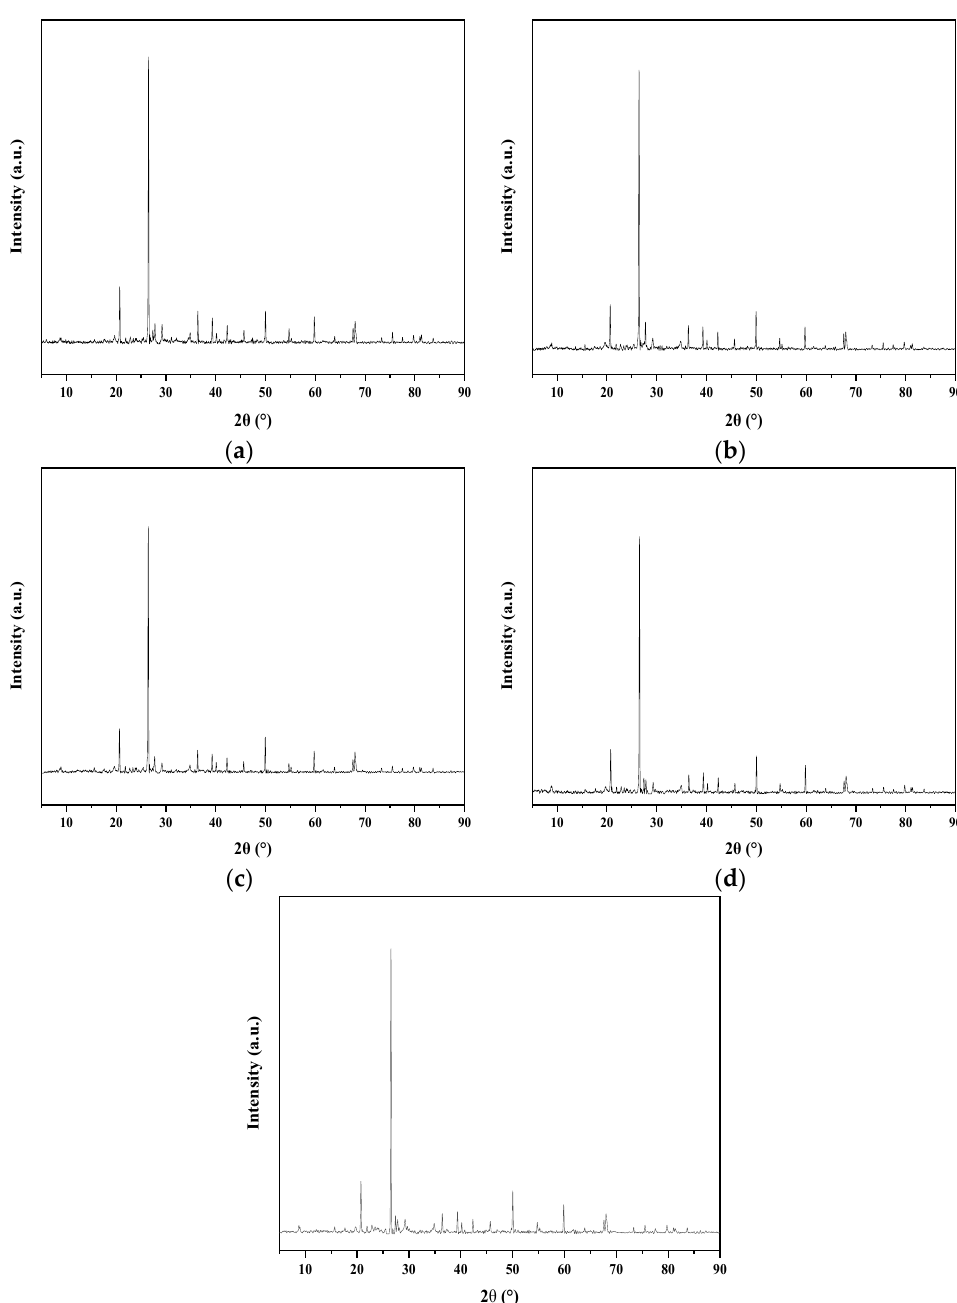
Figure 4. XRD spectra of sample under different recycled fine aggregate contents: ( a ) 10% recycled fine aggregate; ( b ) 20% recycled fine aggregate; ( c ) 30% recycled fine aggregate; ( d ) 40% recycled fine aggregate; ( e ) 50% recycled fine aggregate.